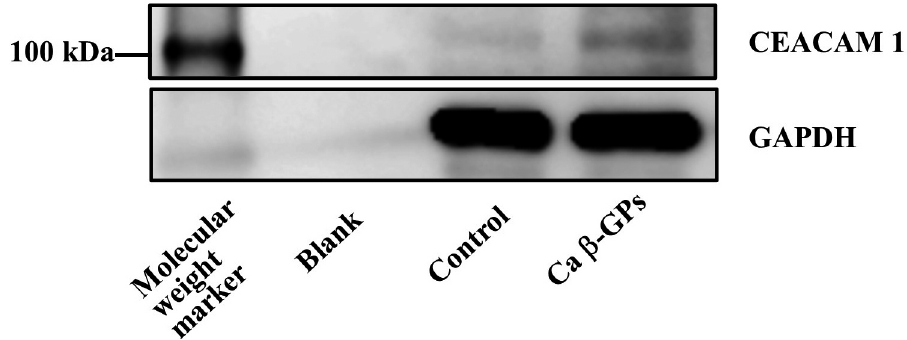
Figure 4- Effects of C. albicans β-GPs on CEACAM1 protein expression in RT7 cells Cells were incubated with C. albicans β-glucan-containing particles (CA β-GPs) (200 μg/mL) for 24 hours. Cell extracts were subjected to SDS-PAGE and western blotting with antibodies against CEACAM1 and GAPDH. The experiments were performed at least three times, with representative results shown.